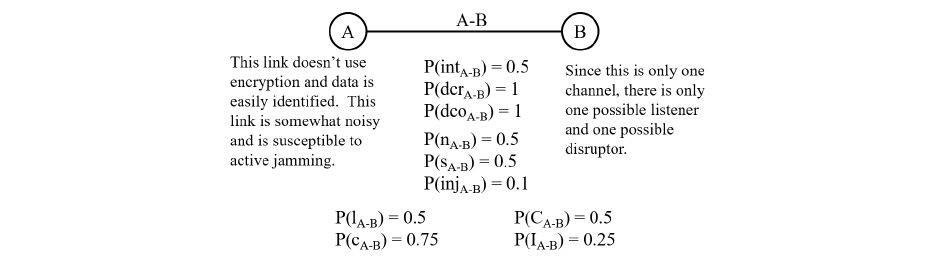
Figure 3. A Single-Channel, Point-to-Point Network and QoSS